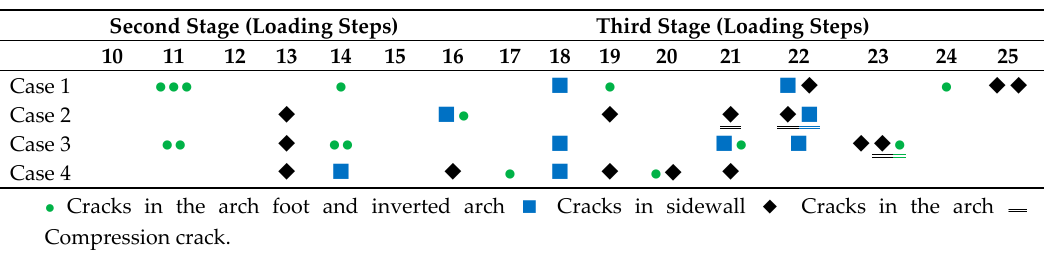
Table 7. Cracks distribution in each loading step.